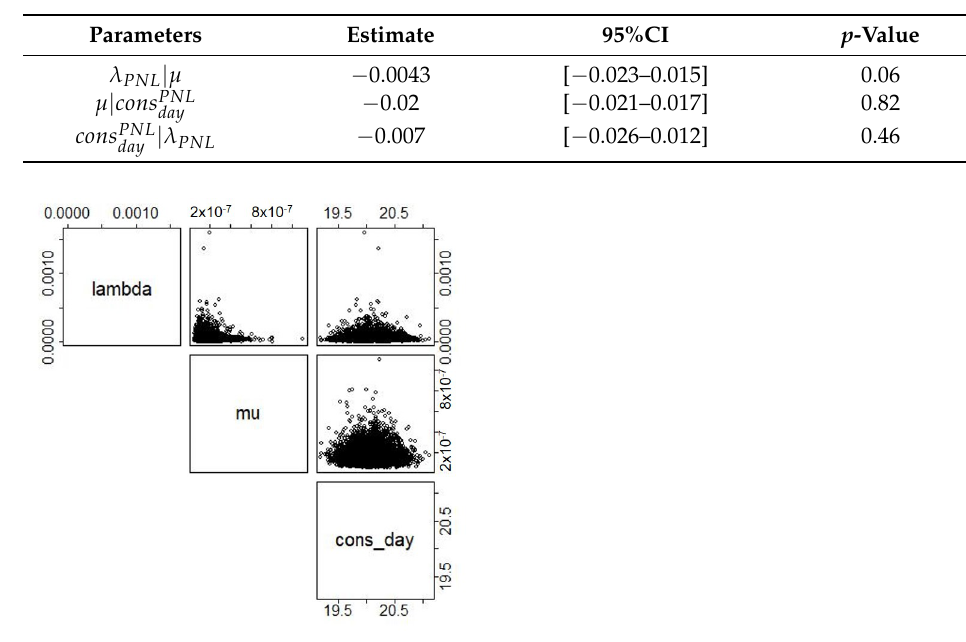
Figure A2. Scatterplots paired between input parameters for category PL. Table A3. Parameter correlations for category PNL.